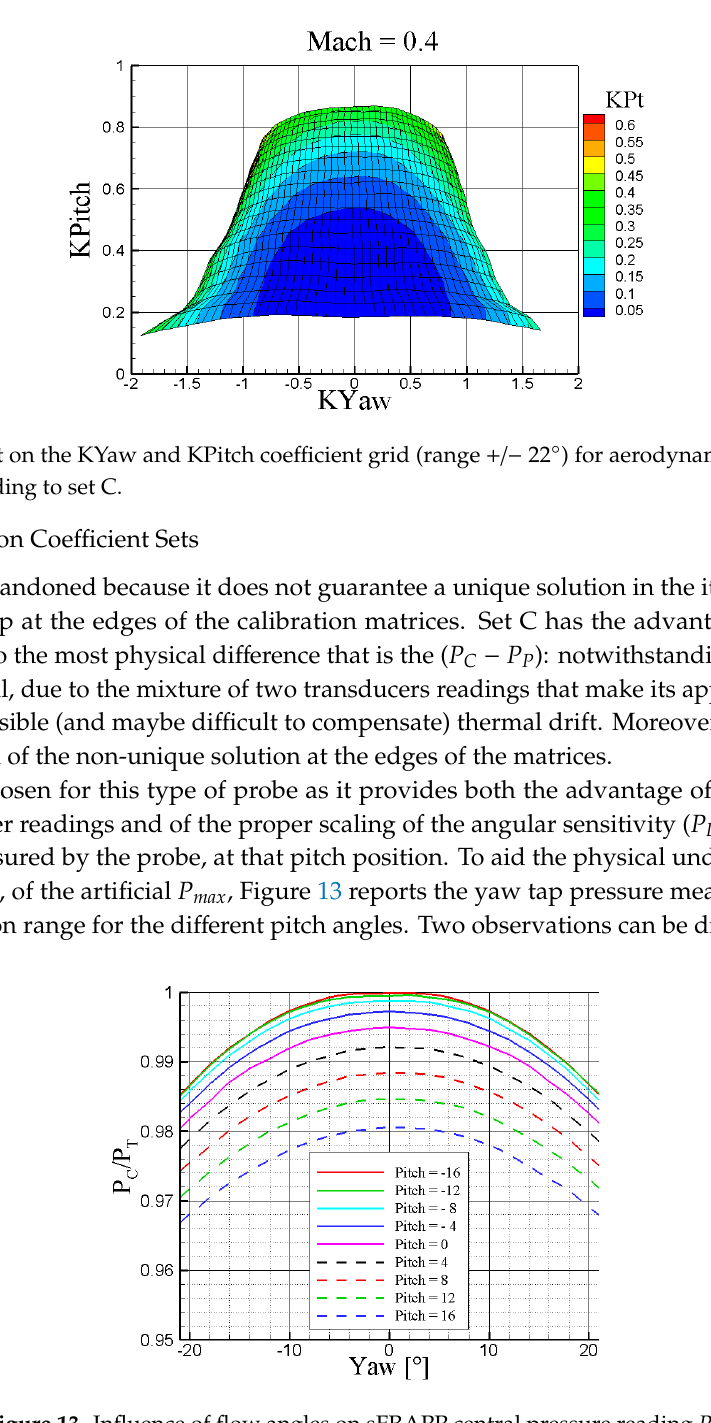
Figure 13. Influence of flow angles on sFRAPP central pressure reading P C.